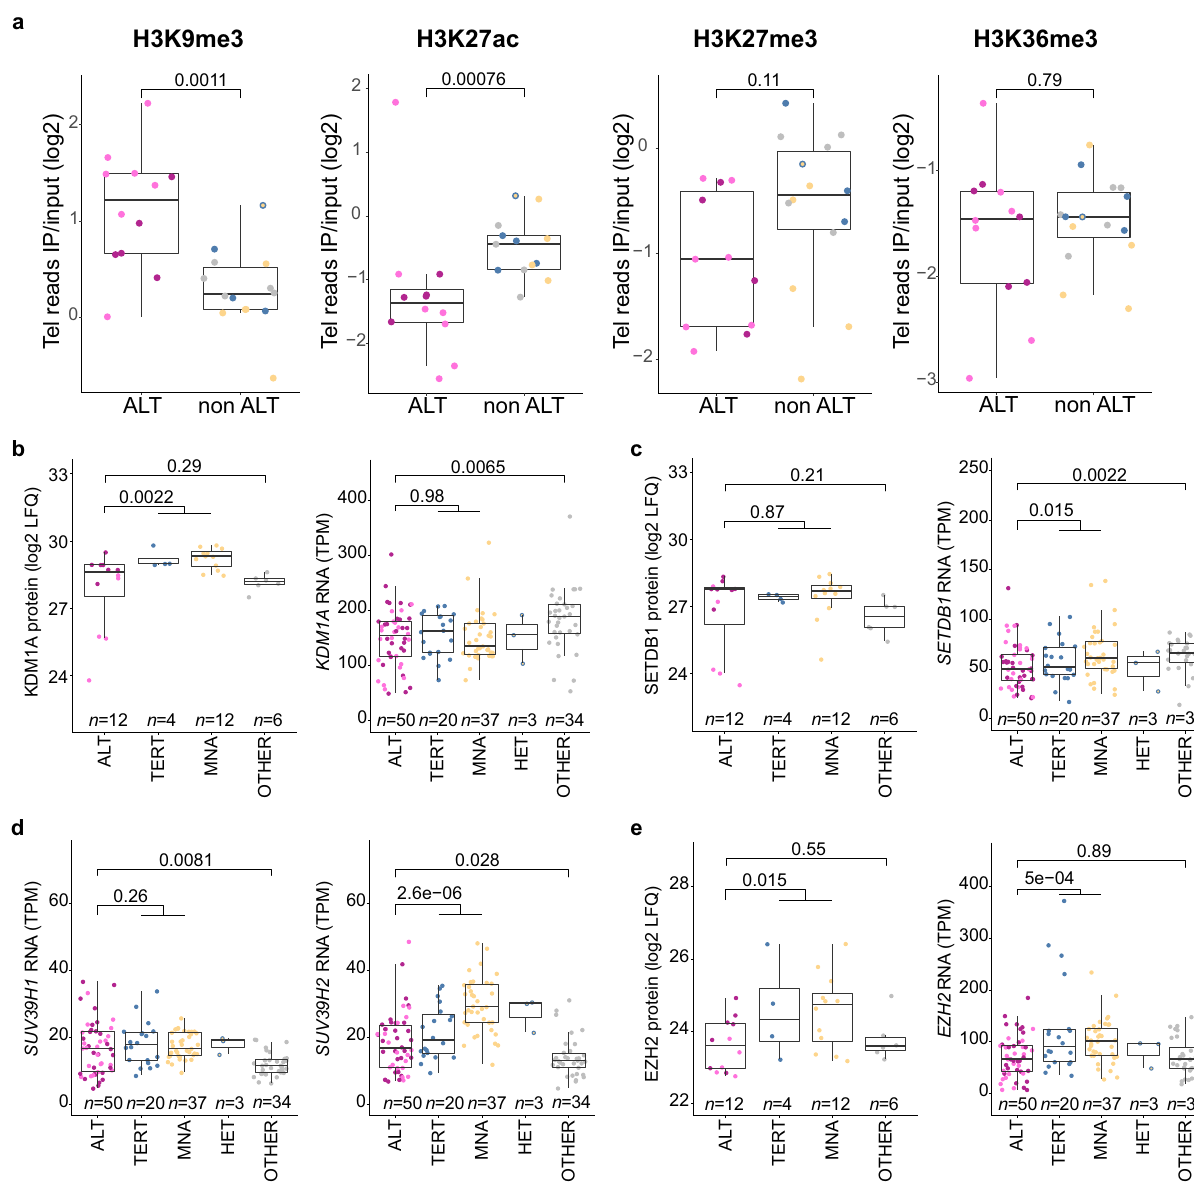
Fig. 6 Telomeric chromatin state of ALT-positive neuroblastomas. a Telomere repeats in ChIP of H3K9me3 ( n = 26), H3K27ac ( n = 25), H3K27me3 ( n = 25) and H3K36me3 ( n = 27) relative to telomere repeats in input of ALT-positive and ALT-negative tumors. b – e Protein and mRNA expression of KDM1A ( b ), SETDB1 ( c ), SUV39H1/H2 ( d , only RNA), and EZH2 ( e ) in ALT tumors compared to tumors form the other groups (TERT, MNA, OTHER). a – e Colors indicate subgrouping based on presence and type of telomere maintenance mechanism (see legend). Boxplots indicate the median value (middle line) and the 25th and 75th percentiles (box). The upper/lower whisker spans from the hinge to the largest/smallest value (values expanding a distance of 1.5 x inter quartile range are not considered). Dots represent individual tumors. P values were calculated using a two-sided Wilcoxon rank sum test. n describes the number of analyzed